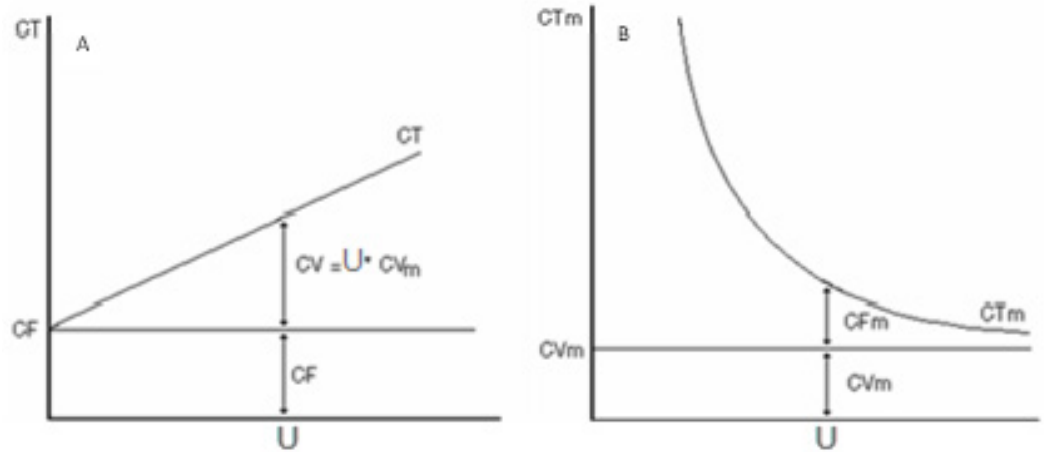
Figure 4: Representation of the impact of units of work processed per year (U) on the: total (CT), fixed (CF) and average variable (CVm) machi- nery costs per year (graph A), or average total (CTm), fixed (CFm) and variable (CVm) machine costs per units of work (right